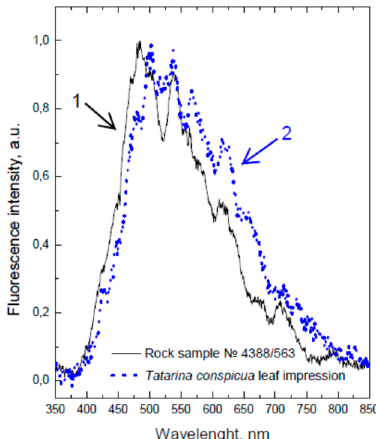
Figure 5. Laser fluorescence spectra of (1) rock sample No 4388/563 and (2) Tatarina conspicua leaf impression with fossilized material residues (the same sample No 4388/563).